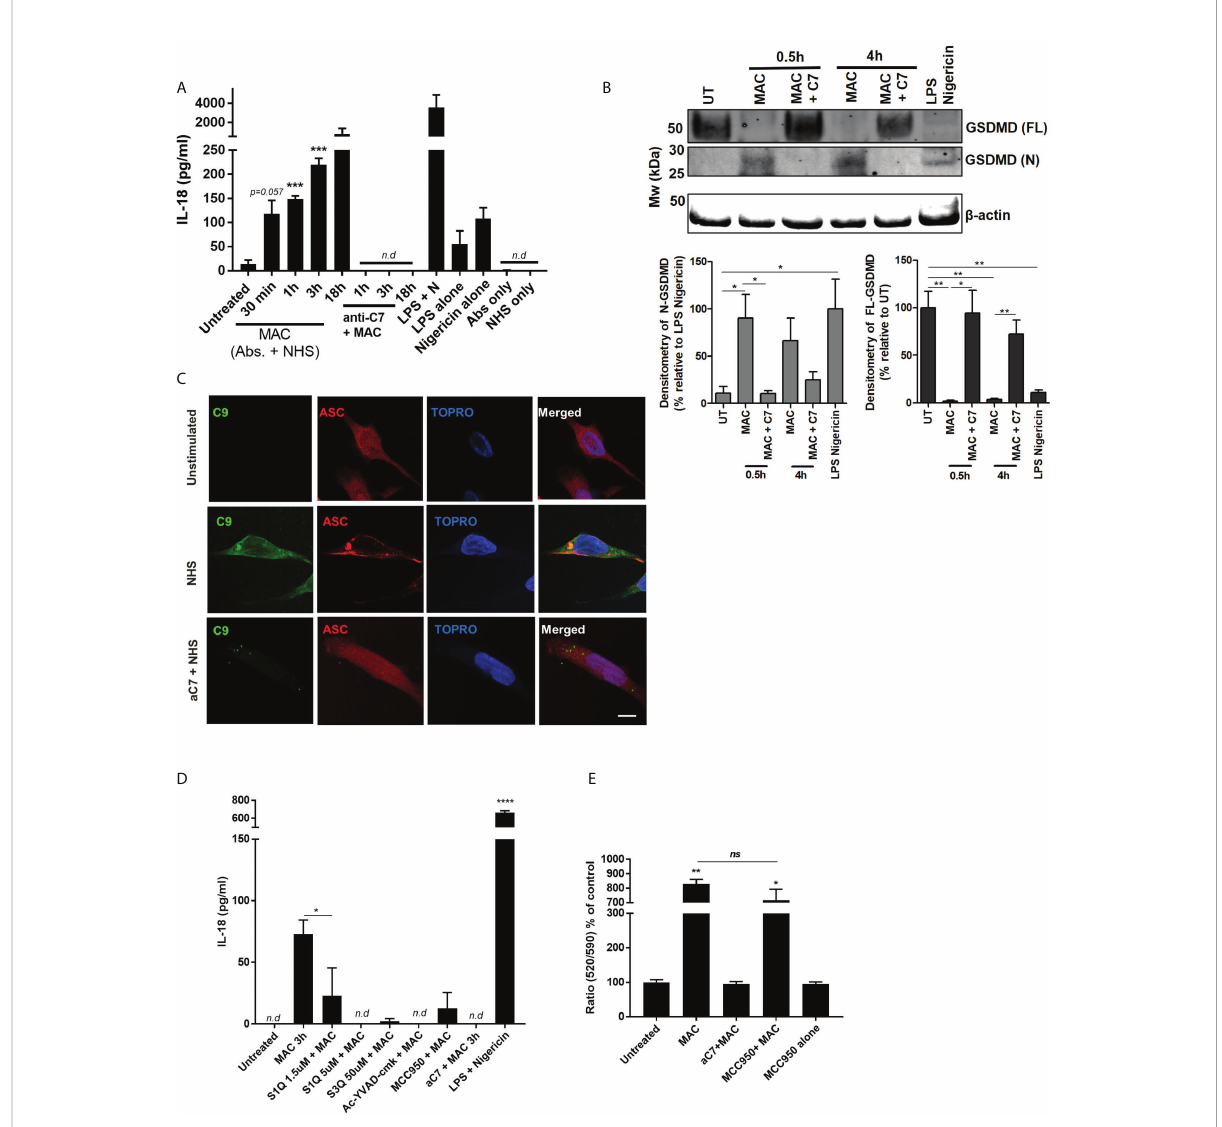
FIGURE 6 NLRP3 in fl ammasome activation in hMDMs triggered by MAC. (A) IL-18 release by hMDMs detected by IL-18 ELISA of supernatants of hMDMs in 1 million cells per condition (24-well plates) stimulated with MAC or indicated controls for select time points. ‘ NHS only ’ is serum only, no antibodies, and ‘ antibodies only ’ is antibodies only, no human serum (n=3) (B) Full length and N-terminal GSDMD as assessed by western blot in hMDMs treated with MAC (+/- anti-C7) for 0.5 or 4 hours, as well as LPS-nigericin (3 h LPS (100 ng/mL) + 1 h nigericin (10 µM)). Representative blot